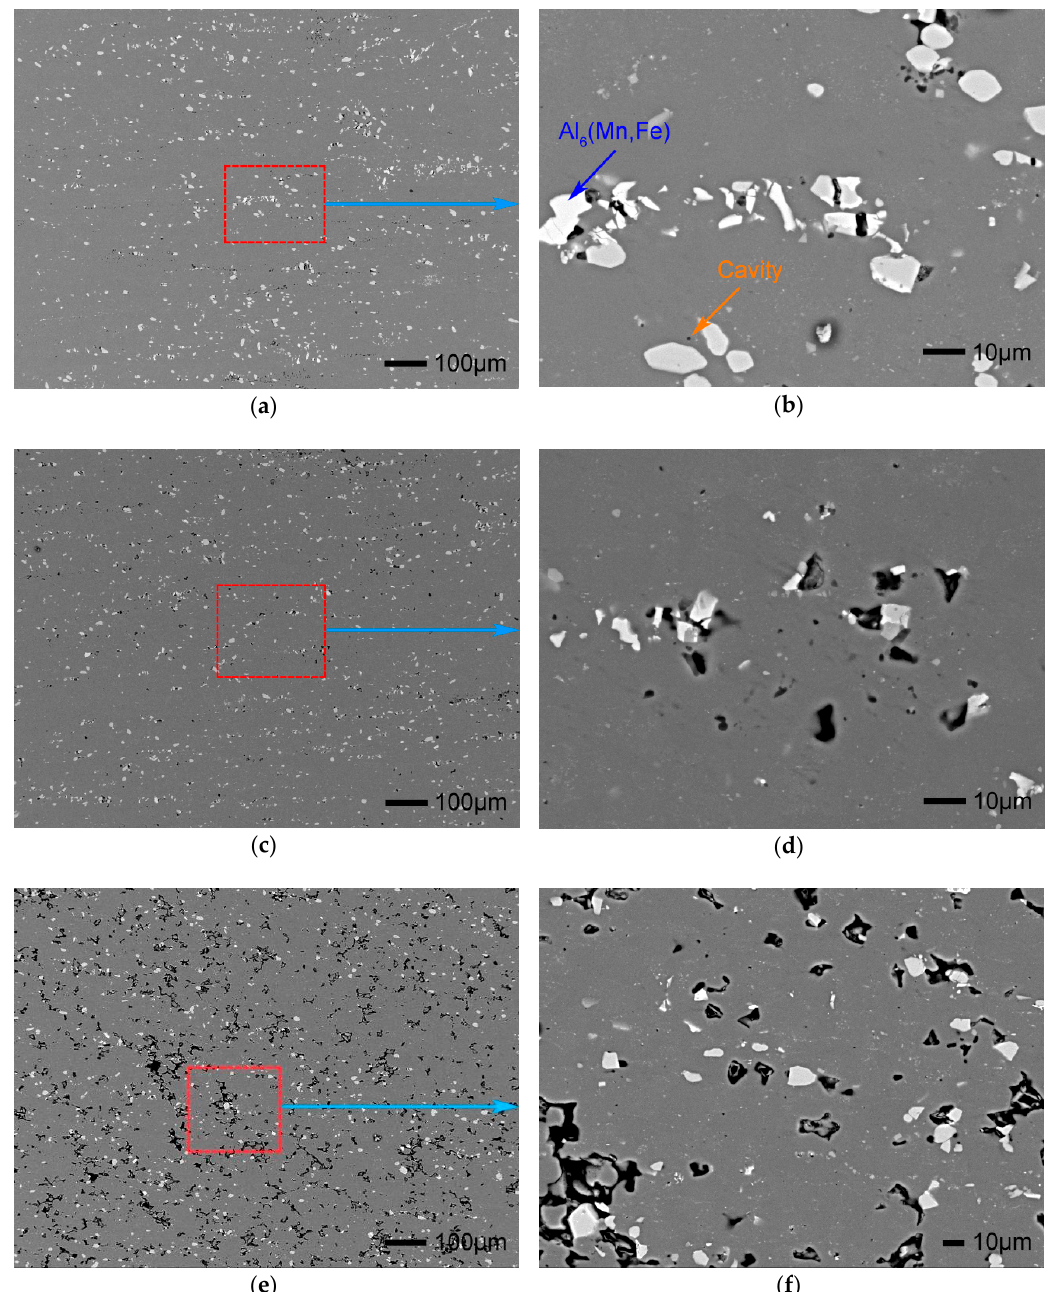
Figure 4. The scanning electron microscopy results in the superplastic tensile stages and magnified regions at 500 °C and 1 × 10 − 3 s − 1 : ε = 0.65 ( a , b ), ε = 1.40 ( c , d ) and ε = 2.65 ( e , f ).